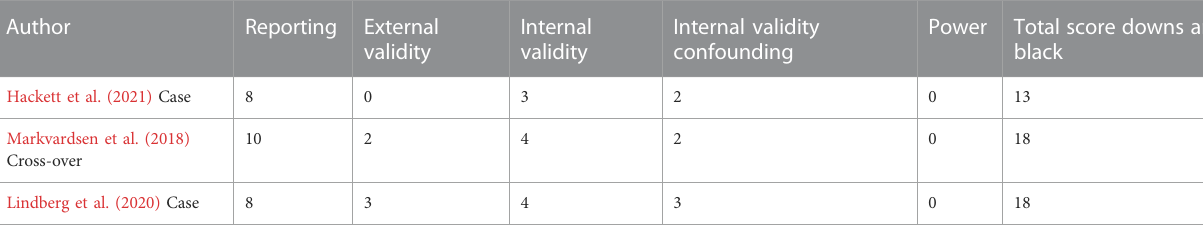
TABLE 4 Sum of quality assessment of case-series and cross-over trial — Downs and Blacks